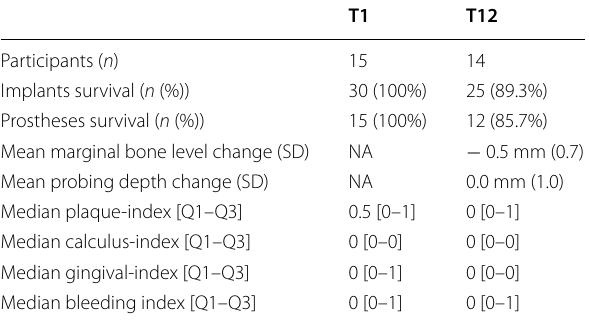
Table 1 Implant and overdenture survival, radiographical and clinical